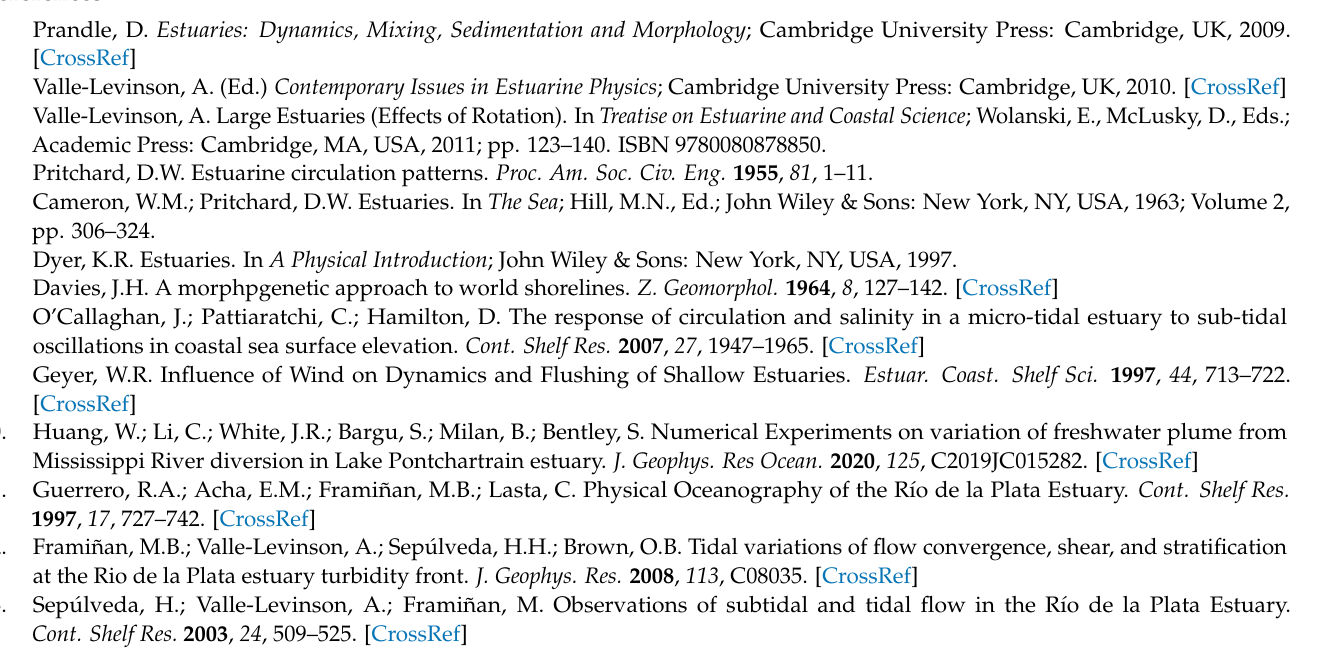
Table A3. Statistics obtained during the validation stage for water levels at PN, TO, and MVD; ve-